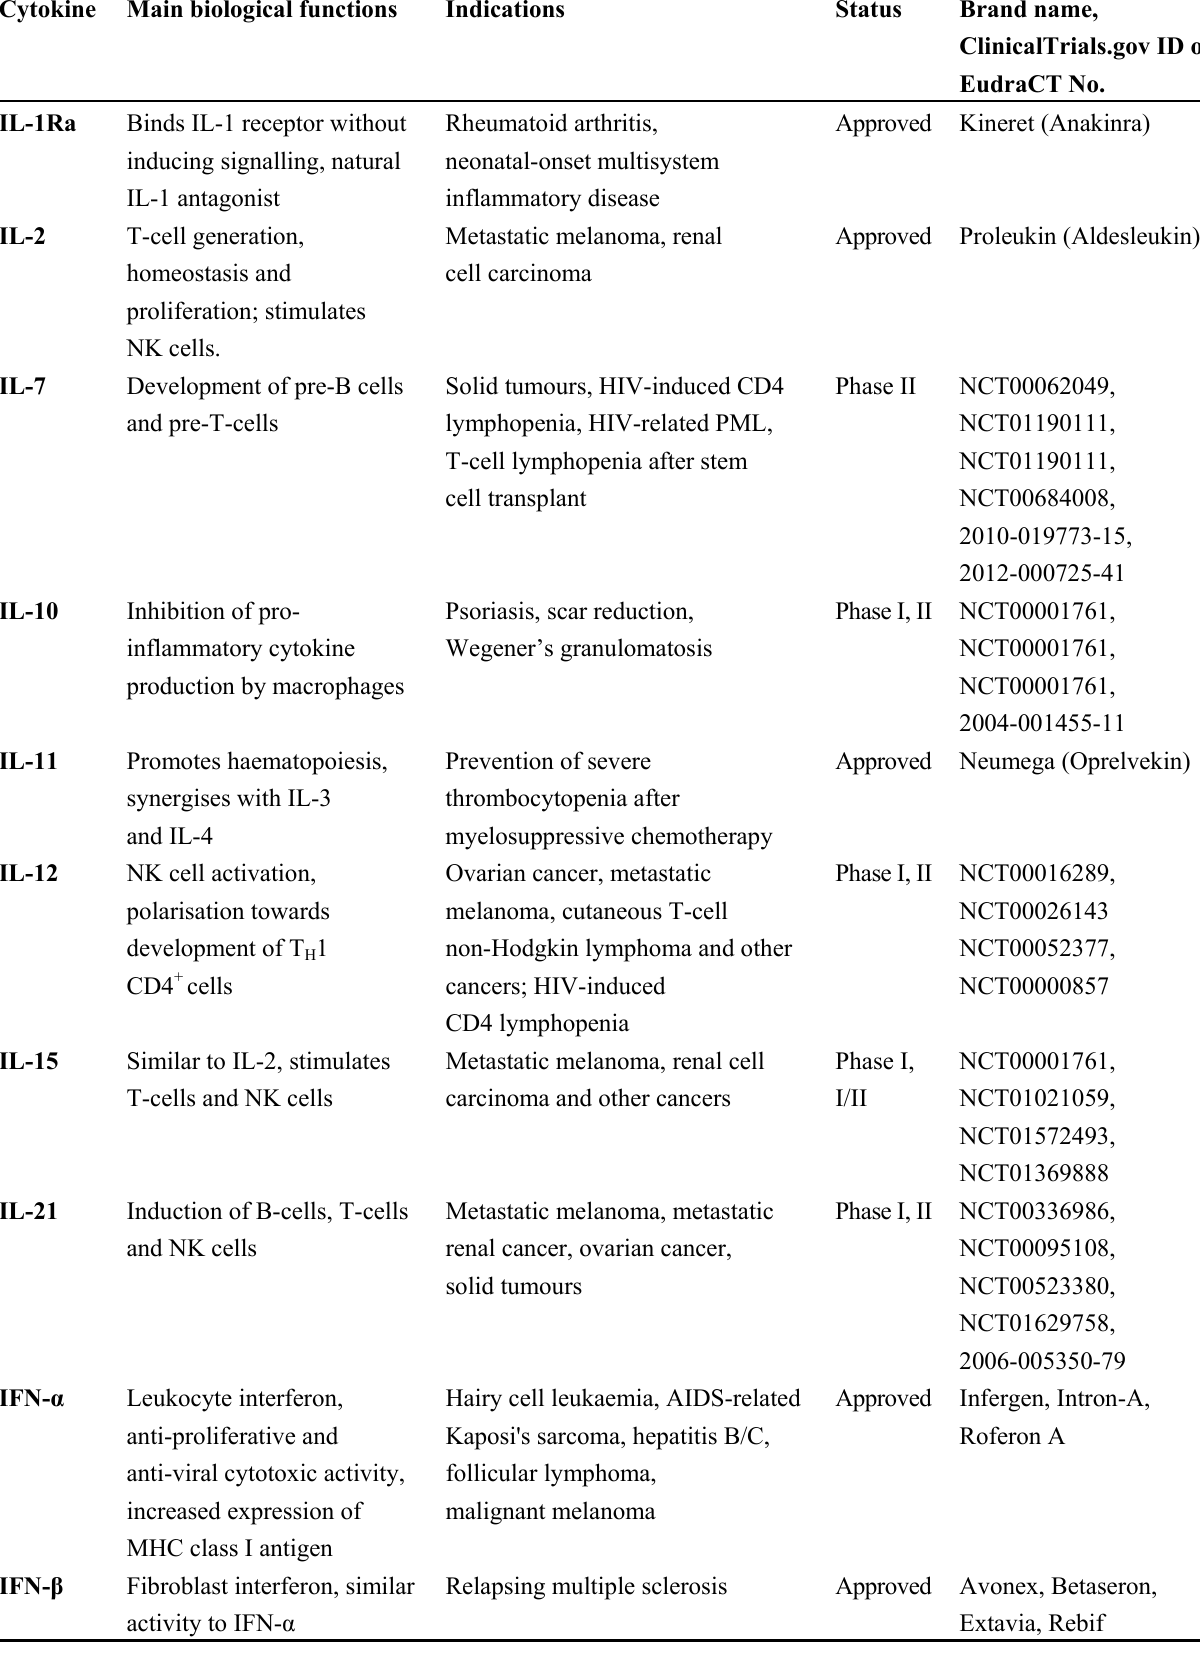
Table 1. Cytokines approved for clinical use or undergoing clinical evaluation.